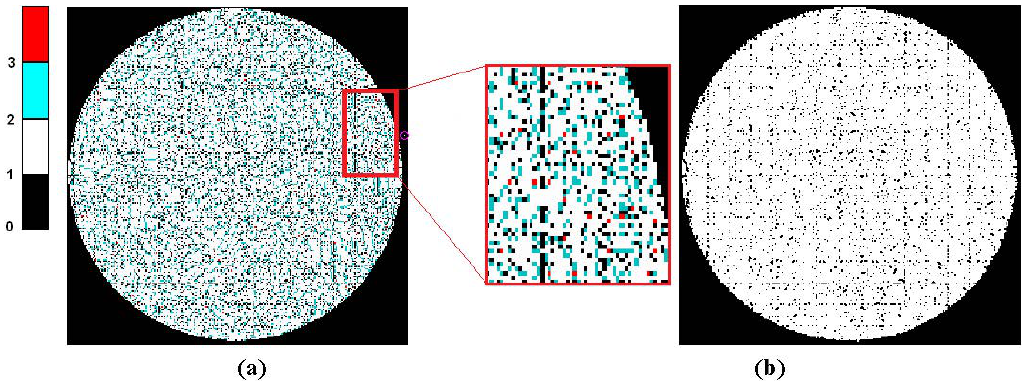
Figure 7. DGSE RAMs. ( a ) RAM for the initial RT; ( b ) Final RAM (binary